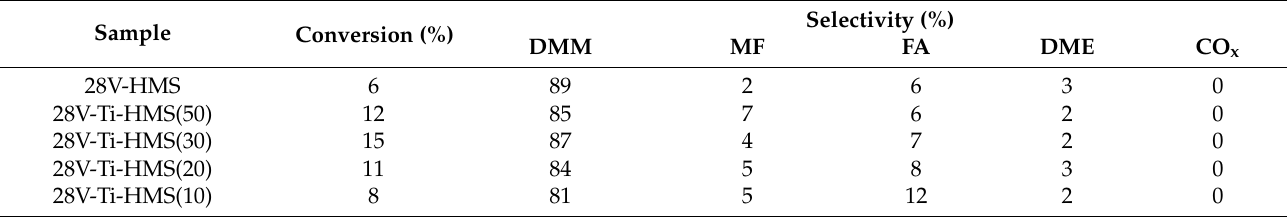
Table 2. Performance of catalysts in the methanol oxidation